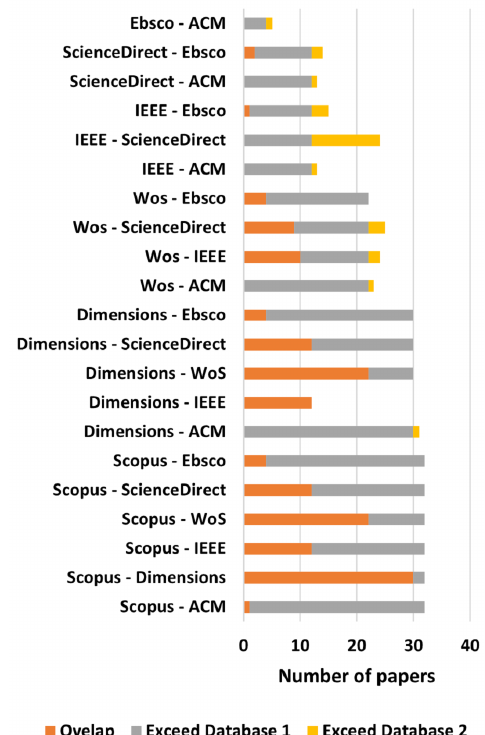
Figure 5. Database